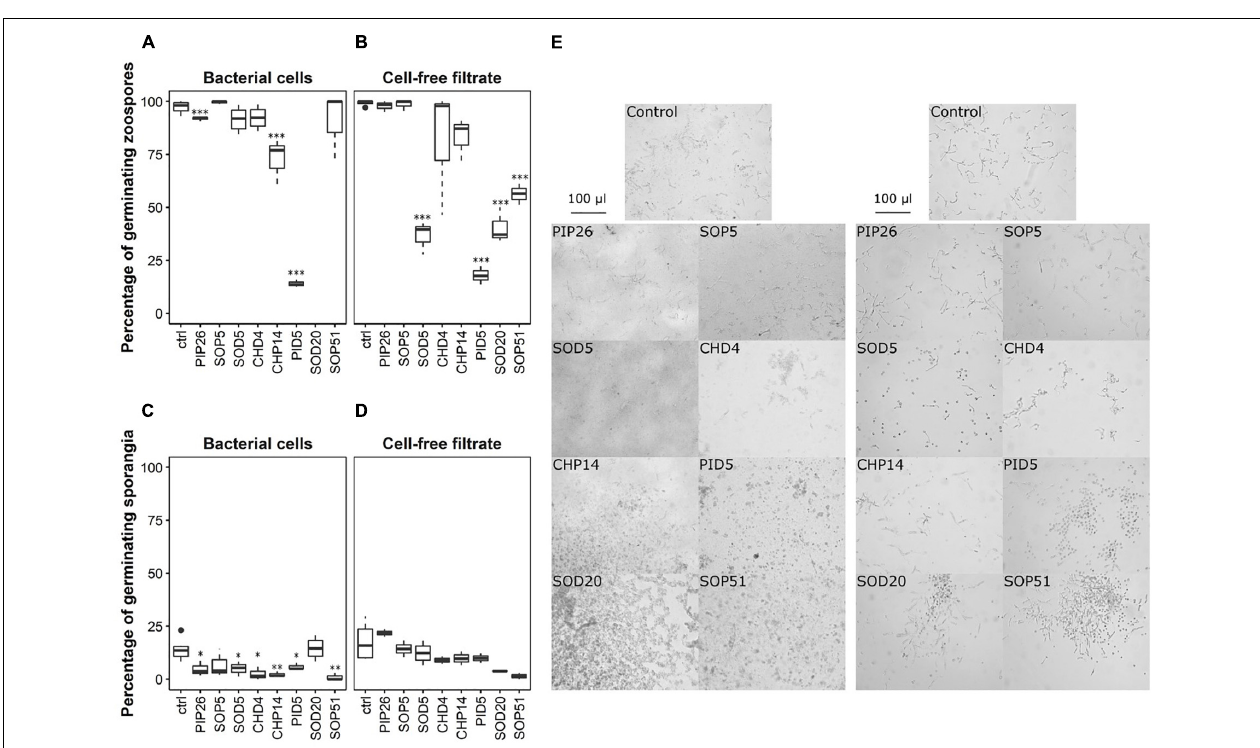
Ten pictures per treatment were examined for the presence of the described phenotypes.